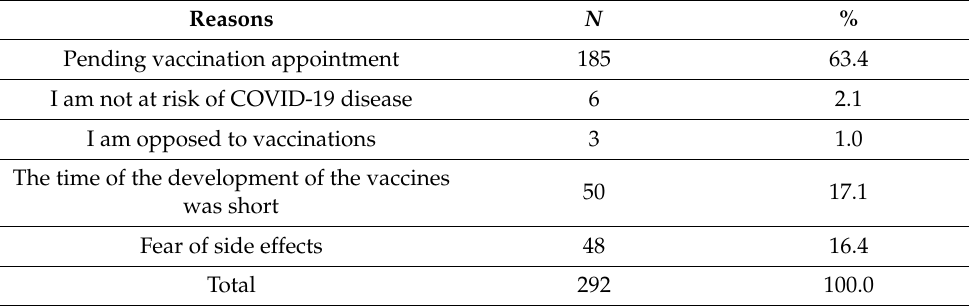
Table 2. Reasons for reported COVID-19 non-vaccination.